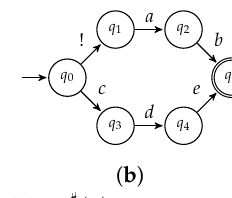
Figure 10. ( a ) A , L ( A ) = { ! Ab , CdE } , ( b ) LC (cid:93) ( A )